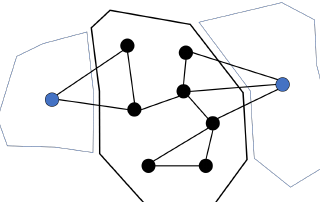
Figure 1. Example single-area system consisting of internal nodes and external nodes representing neighboring